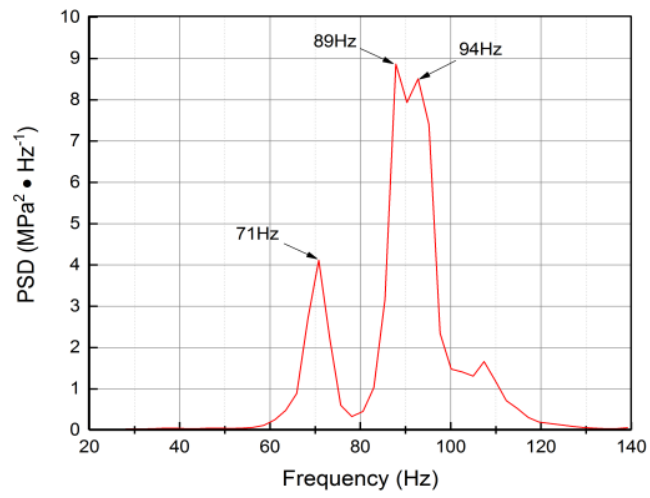
Figure 9. The power spectrum diagram at point D02.